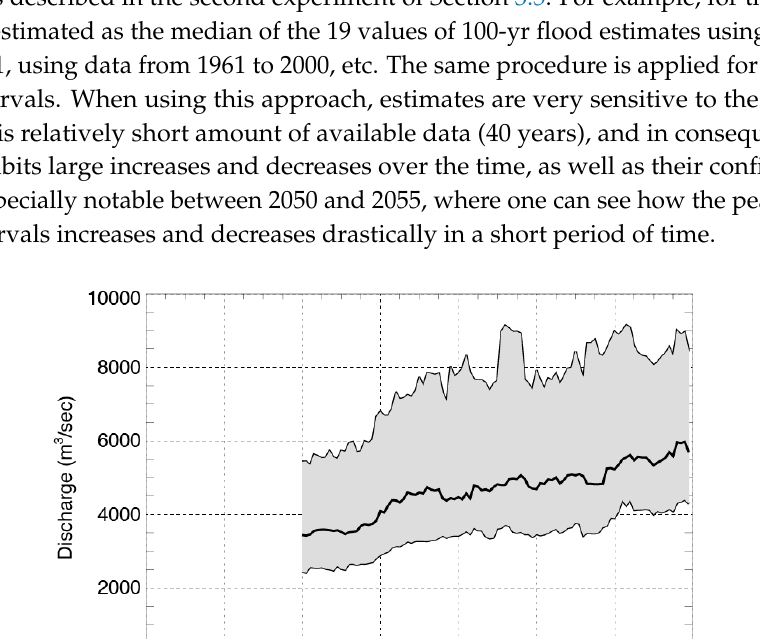
Figure 7. The black solid line is the median of the 19 values of 100-yr flood estimates using the data from a growing time window starting with 40 years in the year 2000 and increments of one year. The shaded area represents the 95% confidence intervals of the estimates.